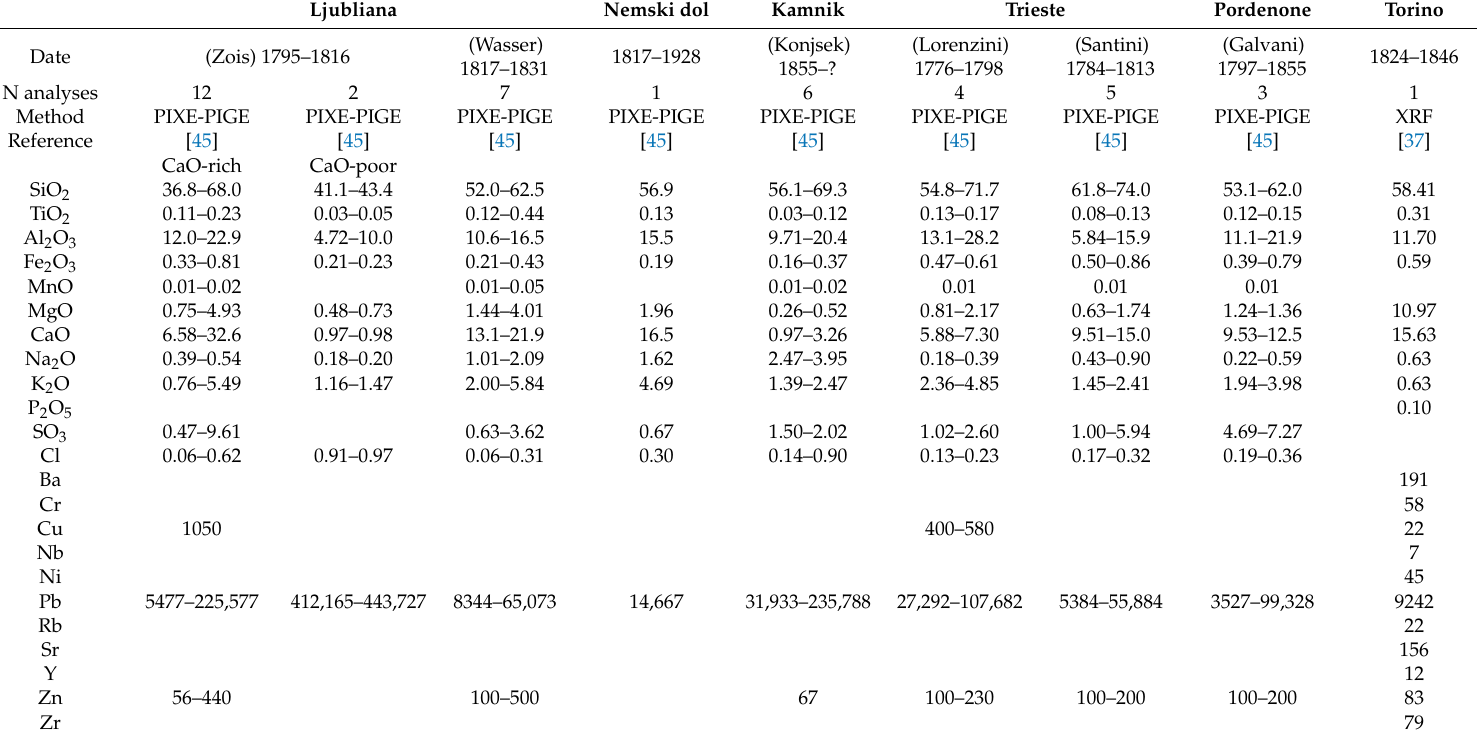
Table 8. Chemical compositions (Min.–Max.) of Slovenian and Italian white earthenwares . Oxides and chlorine in wt %, other elements in